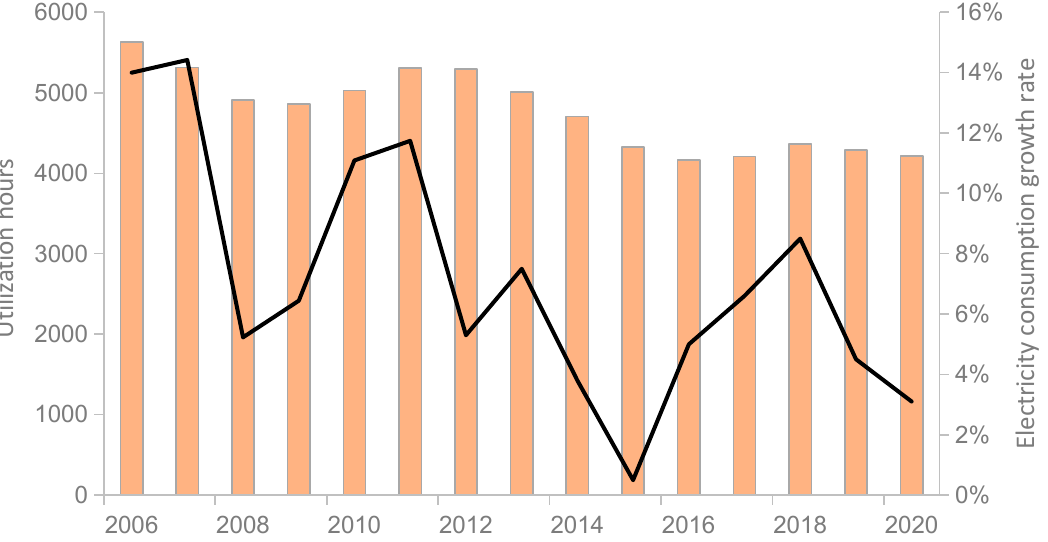
Figure 9. Annual utilization hours and electric consumption growth rate of coal power units.